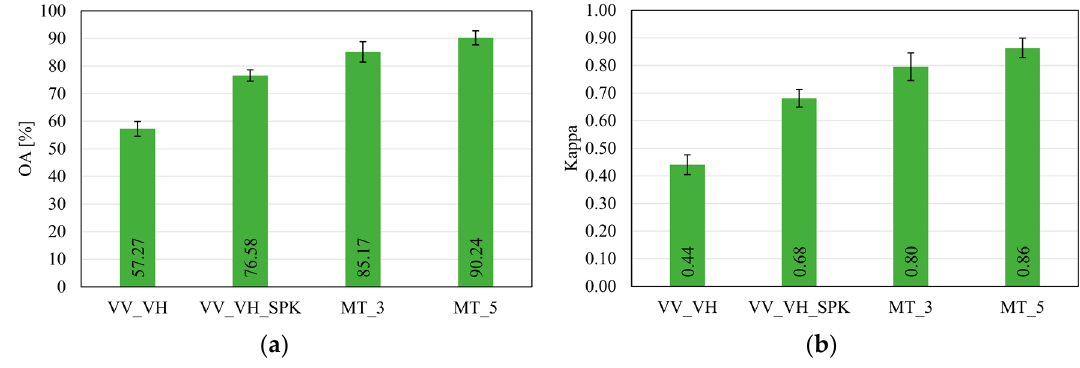
Figure 5. Mean ( a ) OA and ( b ) Kappa values for all machine learning methods used in this research (95% confidence interval). (95% confidence